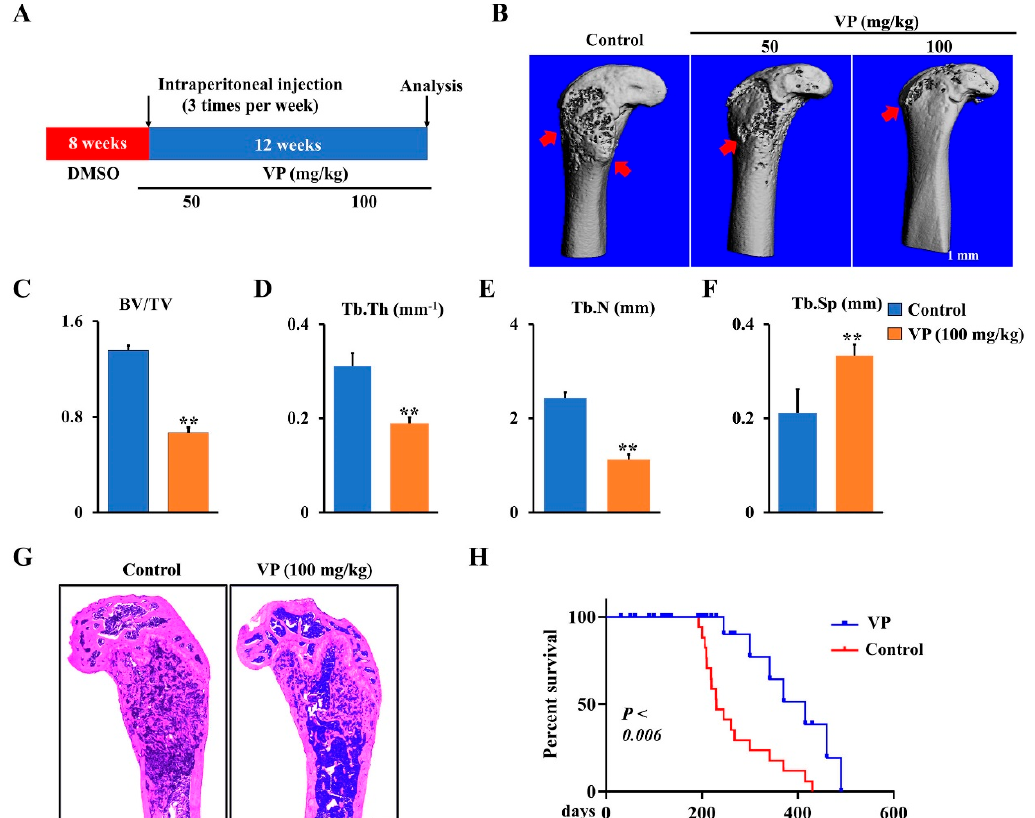
Figure 4. Inhibition of Hippo pathway by VP inhibits osteosarcoma progression in Ctsk-Cre;Trp53 f/f /Rb1 f/f mice. ( A ) Schematic diagram of the time courses of VP injection and mice harvested for data analysis. ( B ) Representative X-ray images of femurs showing that treatment of Ctsk-Cre;Trp53 f/f /Rb1 f/f mice with VP 3 times per week for 12 weeks starting from 2 months. Scale bars, 1 mm. The red arrows indicate the destruction in the cortical bone. ( C – F ) Histomorphometric analysis of bone parameters in the femurs of Ctsk-Cre;Trp53 f/f /Rb1 f/f mice after treatment with 0 (control) or 100 mg/kg VP as indicated. N = 5 mice/group. ( G ) Representative H&E-stained images of femurs from Ctsk-Cre;Trp53 f/f /Rb1 f/f mice treated with 0 (control) or 100 mg/kg VP for 12 weeks. Scale bar, 1 mm. ( H ) Kaplan–Meier survival analysis indicating overall survival of treated with 0 (control) or 100 mg/kg VP for 12 weeks. Error bars were the means ± SEM from three independent experiments. ** p < 0.01.